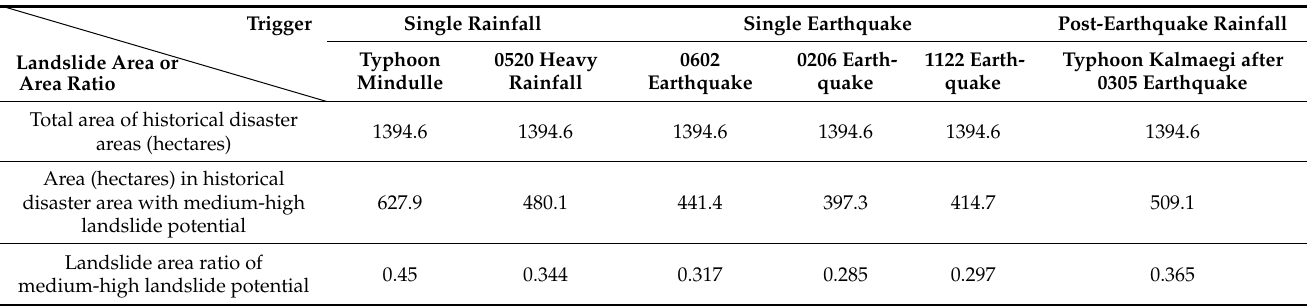
Table 12. Landslide area ratios of medium–high-level landslides induced by rainfall and earthquakes in Alishan Township.